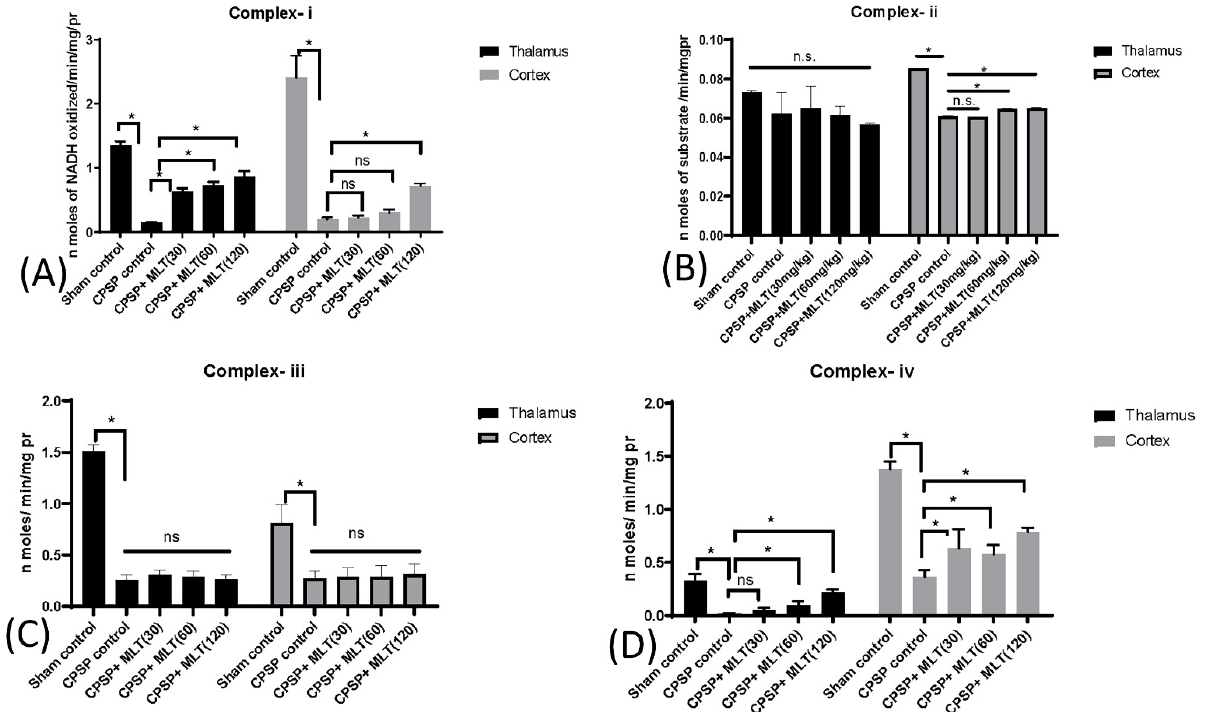
Figure 3. Effect of CPSP and melatonin treatment on mitochondria chain complexes, including ( A ) mitochondrial complex ‐ i (NADH: ubiquinone oxidoreductase; n = 5, per group), ( B ) complex ‐ ii (n = 4, per group), ( C ) complex ‐ iii (n = 5, per group), and ( D ) complex ‐ iv (n = 5, per group) levels in the thalamus and cortex after two weeks of melatonin administration. Data expressed as mean ± SD; * p < 0.005 as compared with CPSP.